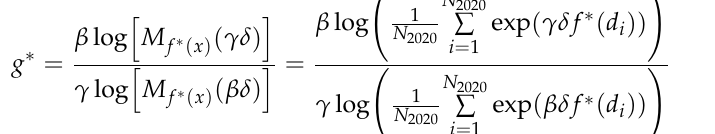
Table 4. Results of the optimal subsidy for storm surge risk index insurance. Proportion of Potential